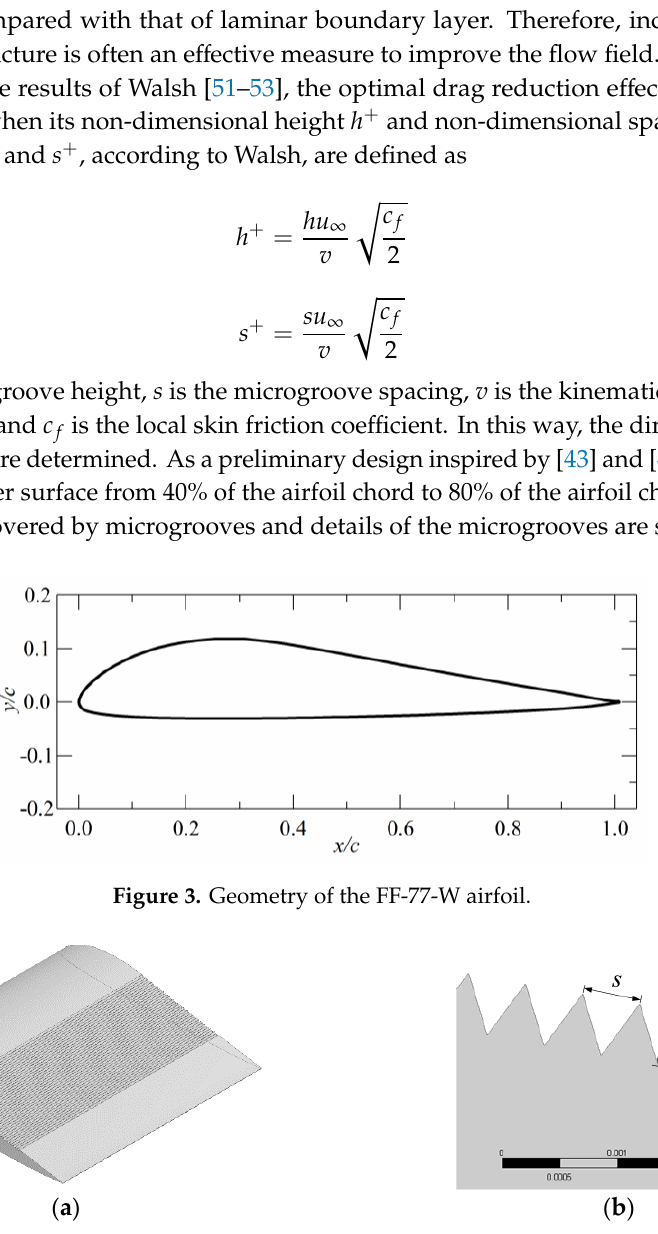
Figure 4. Three-dimensional (3D) hydrofoil partially covered by microgrooves: ( a ) overall model and ( b ) details of microgrooves.